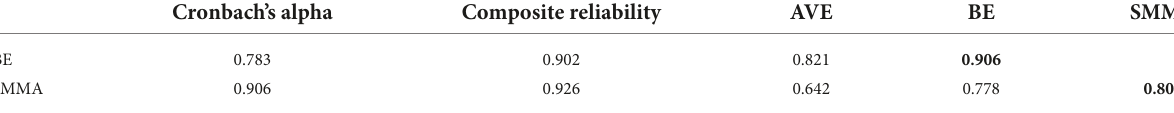
TABLE 7 Higher-order construct reliability and convergence validity, as well as the discriminant validity of Fornell and Larcker criterion.